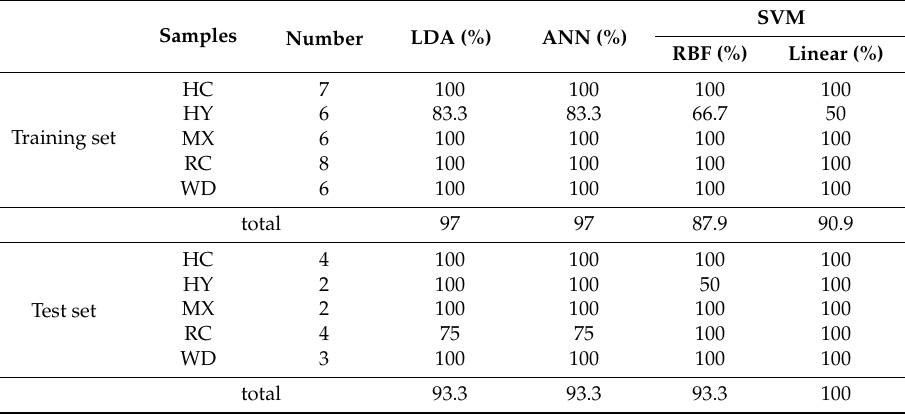
Table 3. Discrimination results (accuracy rate) of different models by electronic nose.